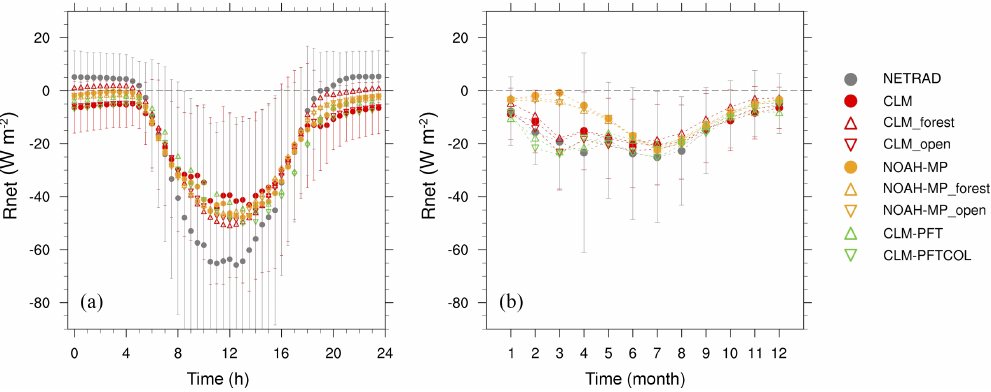
Figure 8. Change in the summer diurnal (a) and seasonal (b) cycles of G (Wm − 2 ) due to LULCC from forest to open land (open − forest). It should be noted that the changes in the CLM-PFT simulation are much further from the observations than the other simulations. Some of its values are beyond the limit of the figure (b) . The smallest value is − 11 . 2Wm − 2 in January, while the largest value is 52.9Wm − 2 in